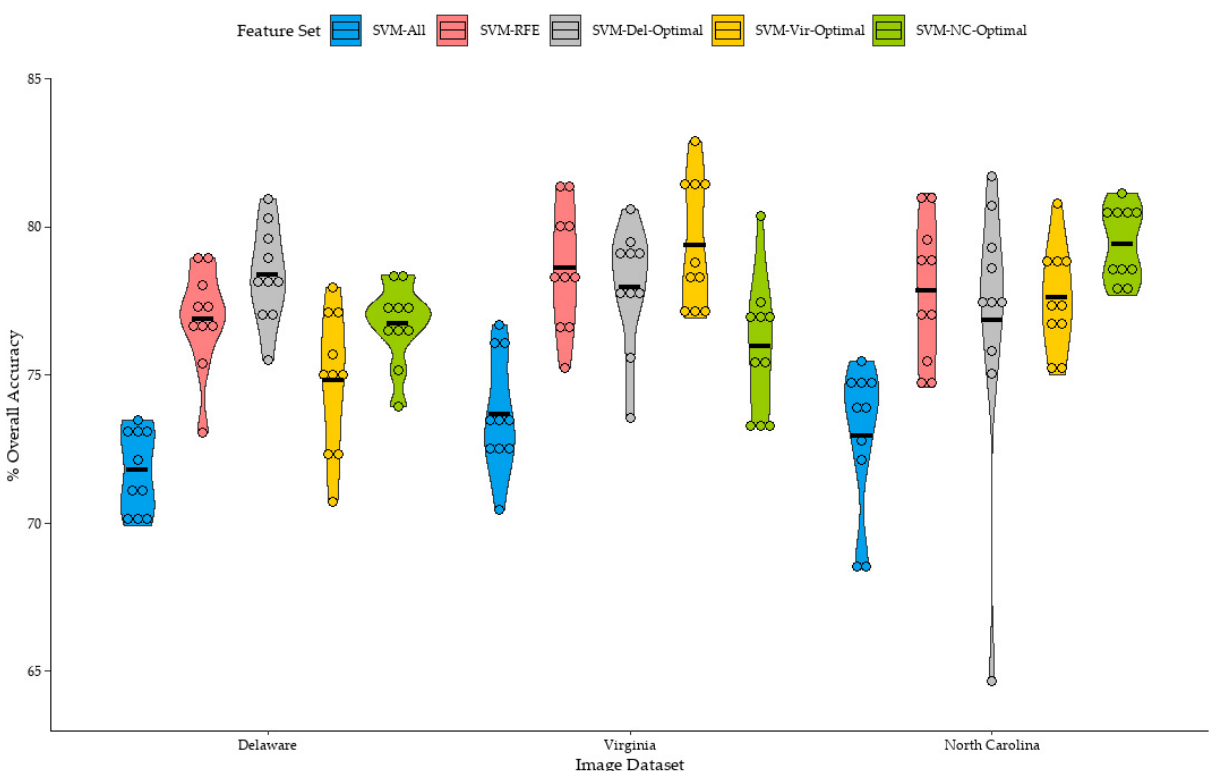
Figure 6. Distribution of overall accuracies of classifications trained from small sample sets. The black horizontal bar indicates the mean overall accuracy for each classification method, while the circles approximate individual overall accuracy values of classifications.